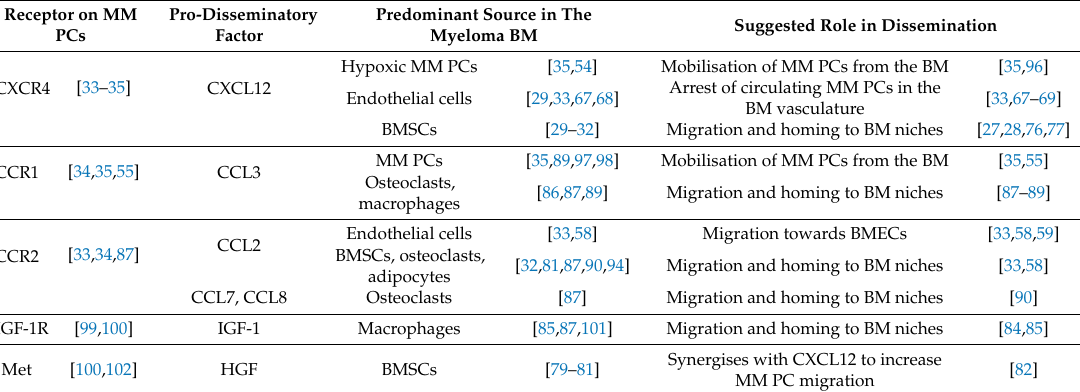
Table 1. Receptors and secreted factors involved in the dissemination process in multiple